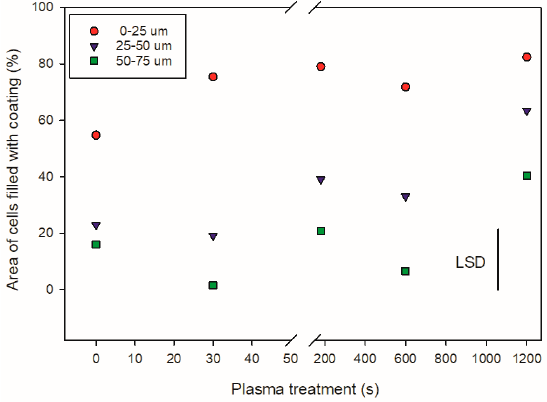
Figure 2. Effects of plasma treatments on the penetration of coating into black spruce wood. Results are expressed as percentage of void space occupied by coating in three zones that extend from wood surface to a depth of 75 µm. Results are averaged across coating type (water- and solvent-borne). The error bar represents Fisher’s least significant difference (LSD) ( p < 0.05) between means in zones 2 and 3.